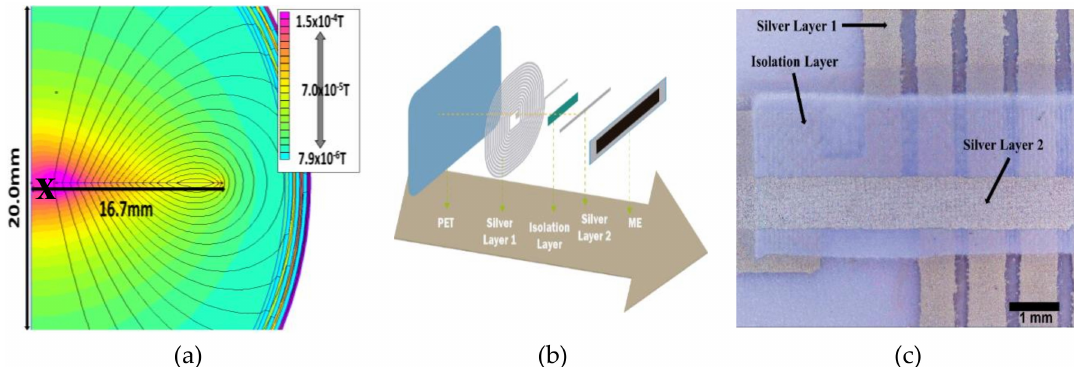
Figure 2. ( a ) Theoretical simulation of the AC magnetic field (in T) generated for a printed coil with a width of 750 µ m, 250 µ m spacing, 15 turns and a current (I) = 0.02 A. ( b ) Schematic representation of